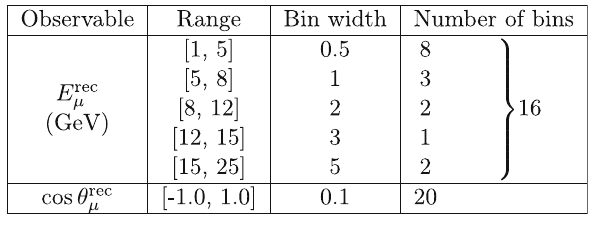
Table 4 The binning scheme considered for E rec μ and cos θ rec μ for μ − and μ + events of 10-year simulated data while we show event distribu- tion and U/D plots in the ( E rec μ , cos θ rec μ ) plane. This binning scheme is used in analysis of oscillation valley as